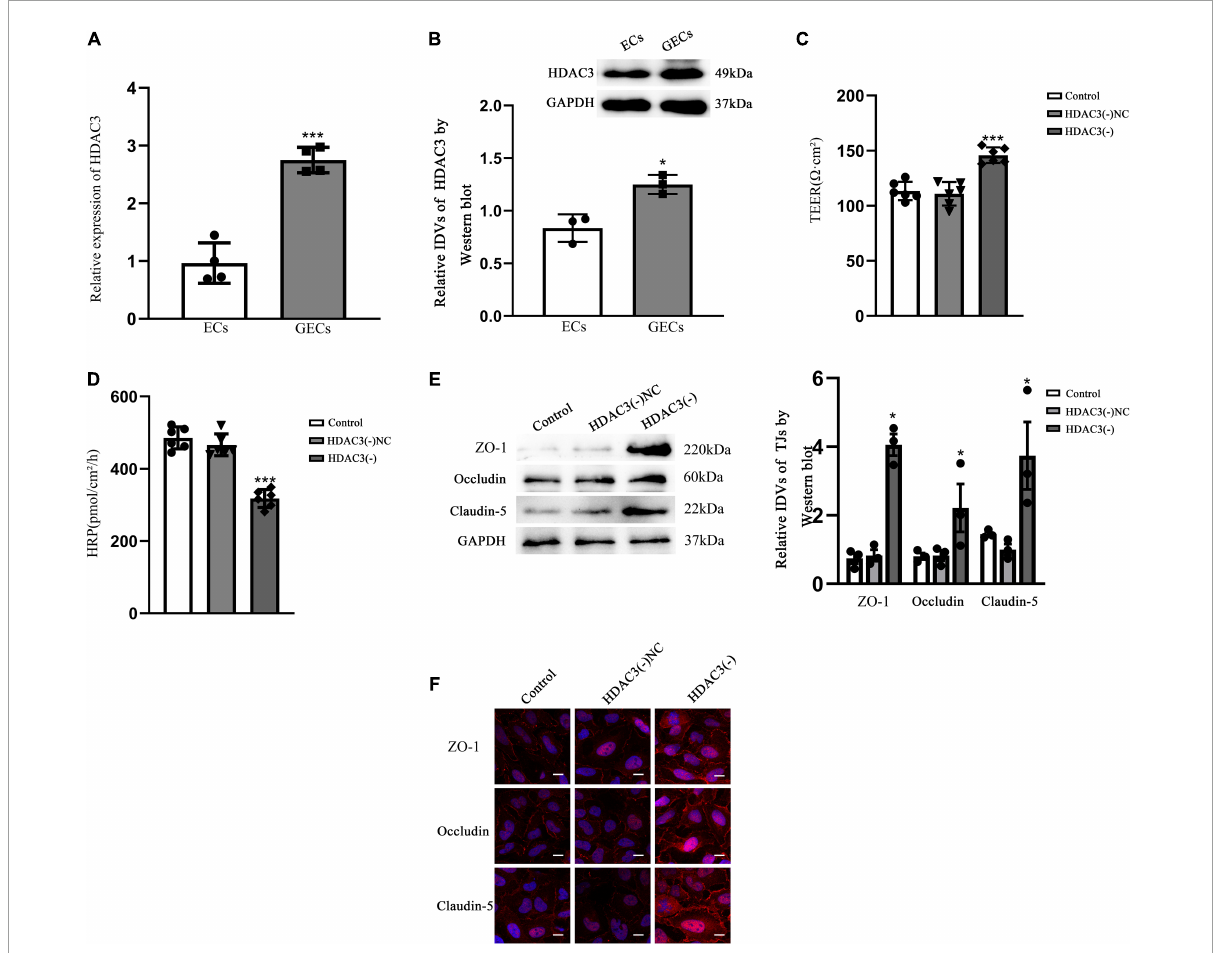
FIGURE4 BTB GECs exhibited endogenous HDAC3 expression and were implicated in the control of the permeability of BTB in vitro (A) QRT-PCR was applied for determine the relative expression of HDAC3 in ECs and GECs. As an endogenous control, GAPDH protein levels were measured. Data represent mean ± SD ( n = 3, each). *** p < 0.001 vs. ECs group. (B) Immunoblotting was used to detect HDAC3 protein expression. As an endogenous control, GAPDH protein levels were measured. Data represent mean ± SD ( n = 3, each). * p < 0.05 vs. ECs group. (C) TEER values of GECs are expressed as (cid:127) cm 2 . Data are expressed as mean ± SD ( n = 3, each group). *** p < 0.001 vs. HDAC3(–) NC group. (D) HRP flow was calculated as pmol/cm 2 /h. Data are expressed as mean ± SD ( n = 3, each). *** p < 0.001 vs. HDAC3(–) NC group. (E) Protein blot analysis of TJ-associated proteins ZO-1, Occludin, and Claudin-5 in GECs. As an endogenous control, GAPDH protein levels were measured. Data are expressed as mean ± SD ( n = 3, each). * p < 0.05 vs. HDAC3(–) NC group. (F) Immunofluorescence localization of ZO-1, Occludin, and Claudin-5 in GECs. The nuclei were marked with DAPI, and fluorescent secondary antibodies were used to mark ZO-1 (red), Occludin (red), and Claudin-5 (red). The pictures showed what happened in three different experiments. Scale bar = 20 µ